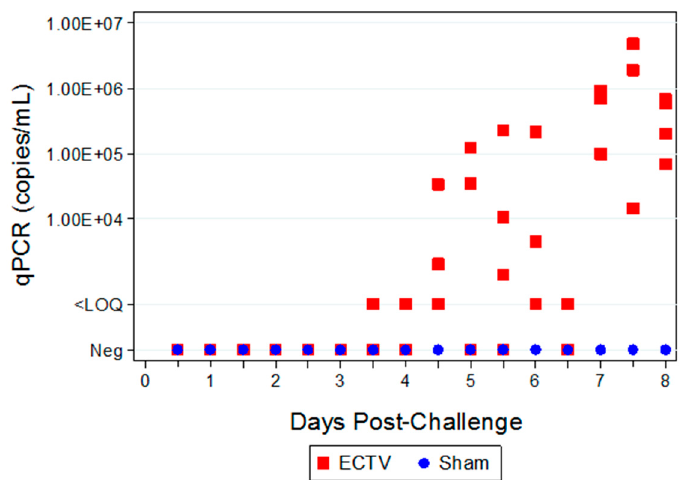
Figure 5. Quantifiable qPCR titers in the blood of ECTV ‐ Mos infected mice were first measured at 4.5 days PI with titers ranging from 2.04 × 10 3 to 3.39 × 10 4 gene copies/mL. Viremia was measured in most animals starting at 5.5 days PI and viral genomic material in the blood increased through 7.5 and eight days PI.